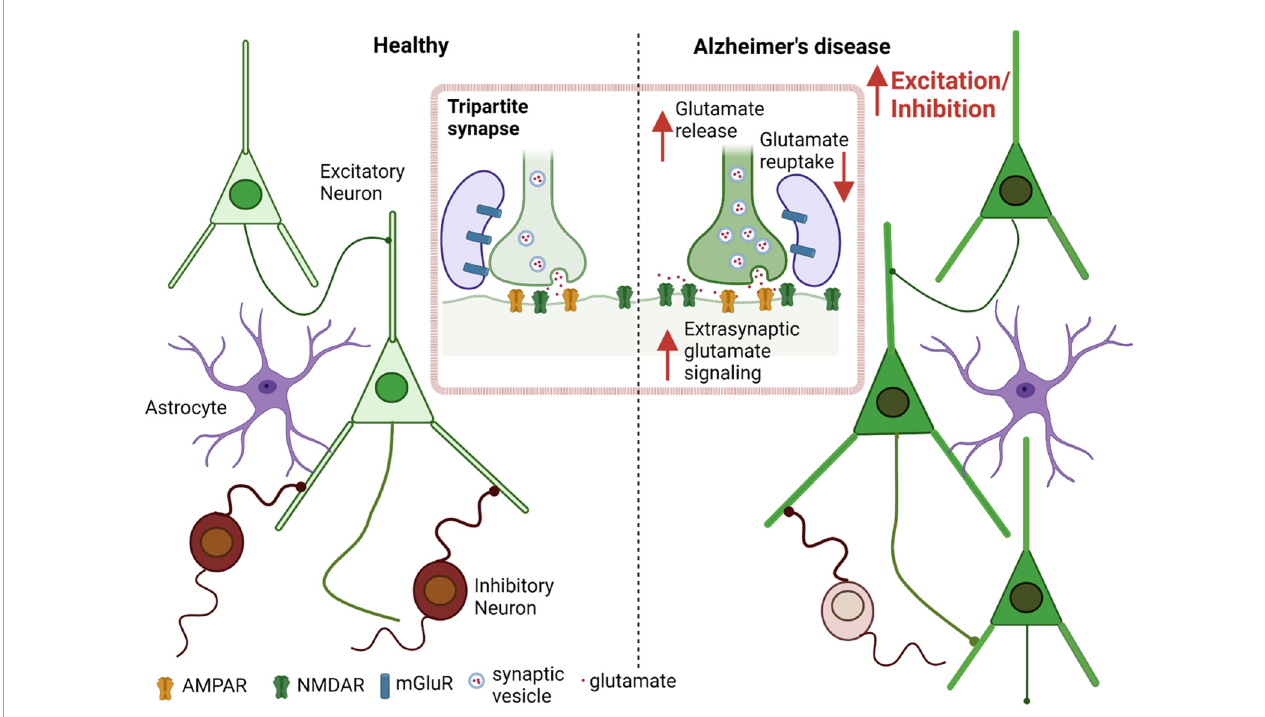
FIGURE1 Aberrant glutamate signaling contributes to E/I imbalance in AD. Increased excitation and decreased inhibition leads to an increased E/I ratio in AD as well as in other neurological diseases such as autism spectrum disorder (ASD) (Ghatak et al., 2021b). Excessive presynaptic glutamate release, disrupted glutamate re-uptake or frank release by astrocytes, and resulting increased (predominantly extrasynaptic) NMDA receptor-mediated signaling leads to increased excitation at the single neuron level, contributing to hyperexcitability in the neuronal network.